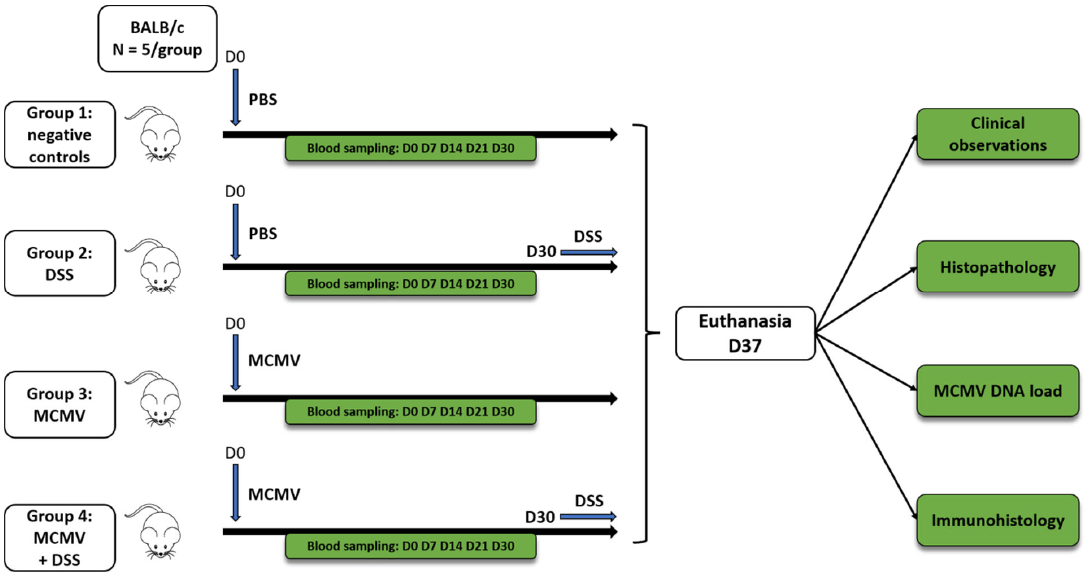
Figure 1. Flowchart of the study. Seven-week-old female BALB/c mice were divided into four groups (5 animals per group): group 1 = negative controls; group 2 = mice treated by dextran sodium sulfate (DSS) in the drinking water from D30 to D37; group 3 = mice infected by murine cytomegalovirus (MCMV) at D0; and group 4 = mice infected by MCMV at D0 then treated by DSS in the drinking water from D30 to D37.